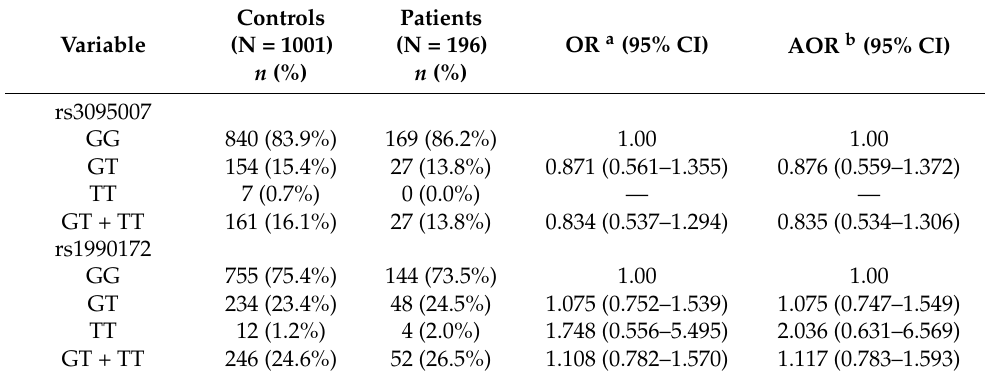
Table 4. The MACC1 SNPs genotype frequencies of people who didn’t used to chew betel